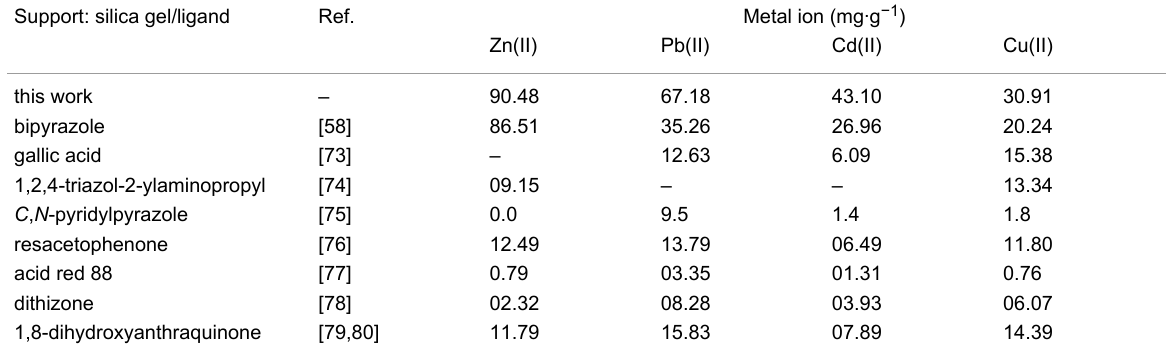
Table 6: Comparison of adsorption capacity of SiNL with selected reported sorbents. Support: silica